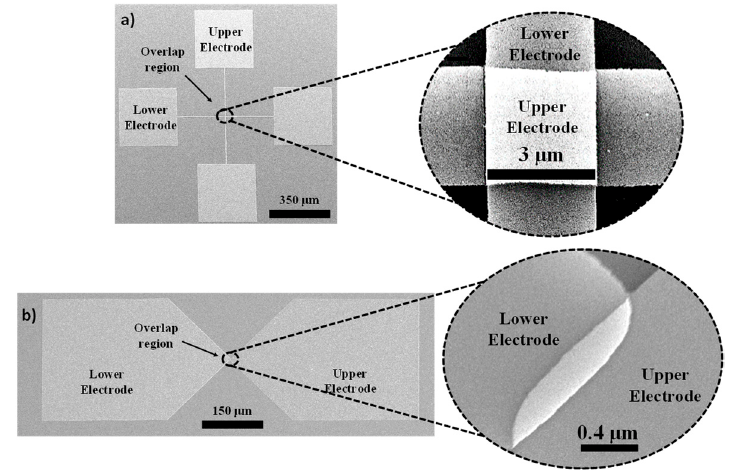
Figure 7. High-resolution SEM images of ( a ) square-overlap layout ( b ) point-overlap layout with zoomed-in images of their overlap regions.